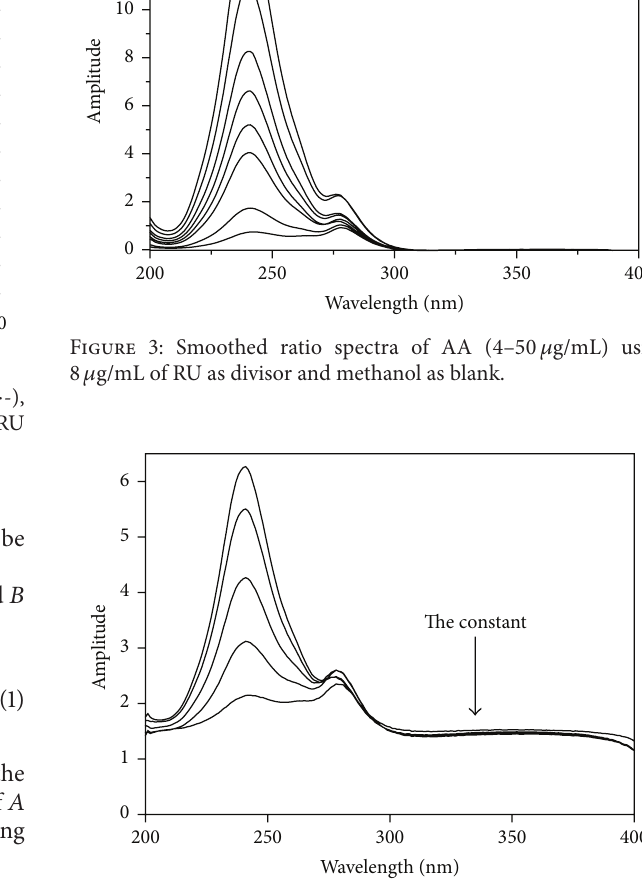
Figure 4: Ratio spectra of laboratory prepared mixtures of AA ( 𝑋 ) and RU ( 𝑌 ) using 8 𝜇 g/mL of RU ( 𝑌 󸀠 ) as a divisor and methanol as